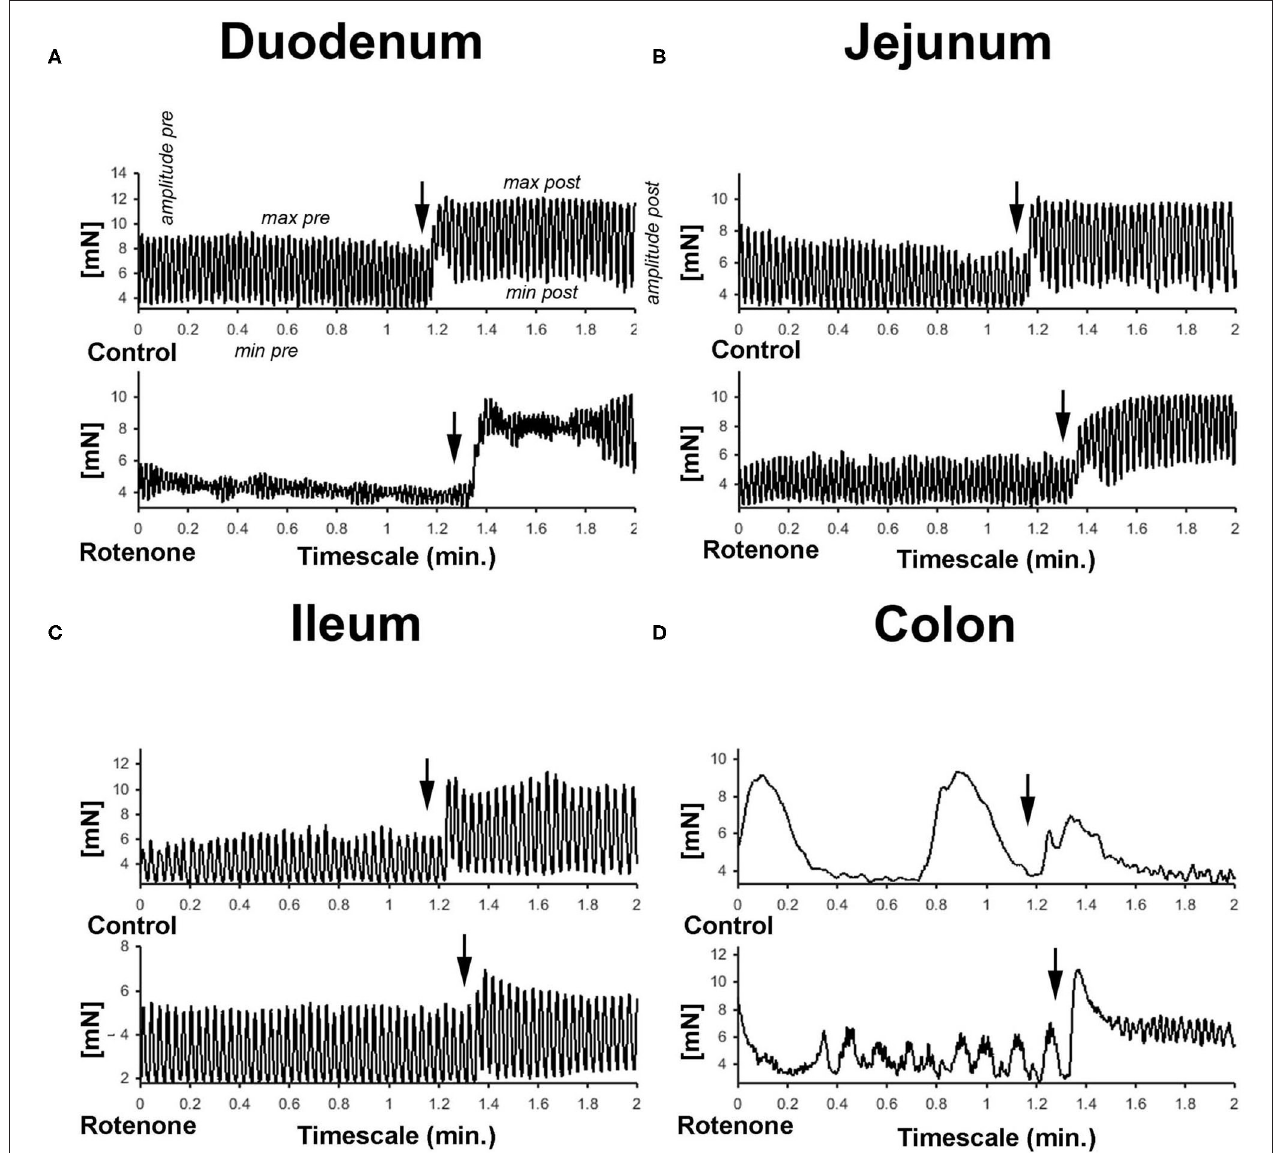
FIGURE 1 | (A–D) Graphic showing representative examples of the force generated by the peristaltic movements and the effect of carbachol in the different gut segments in mN. Arrows in all graphics indicates the moments carbachol was added to the